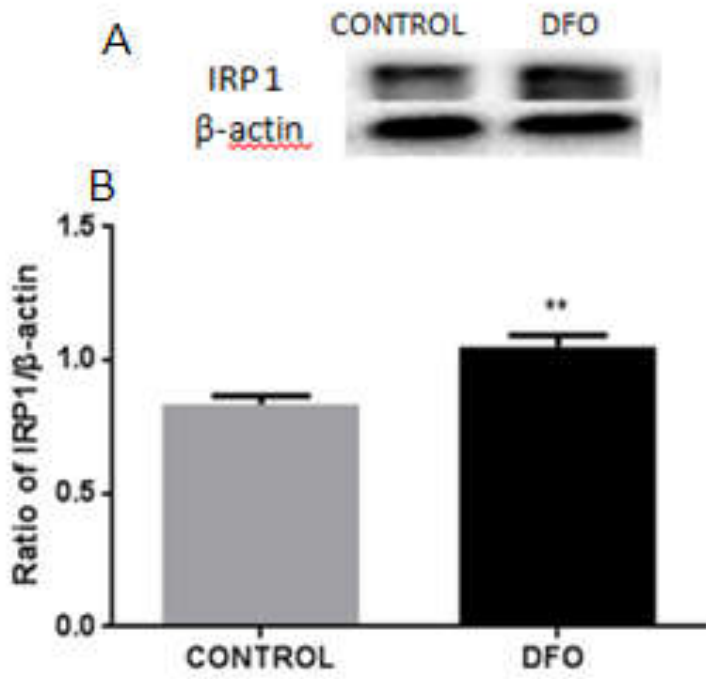
Figure 9. Protein levels of IRP1 in DFO-treated BV2 cells. ( A ) Western blot analysis of IRP1 protein levels. The expression of IRP1 increased in 100 µ M of DFO treated-BV2 cells. β -actin was used as the loading control. ( B ) Data are presented as the ratio of IRP1 to β -actin level. Each bar represents the mean ± SEM from six independent experiments ( n = 6), ** p < 0.001.